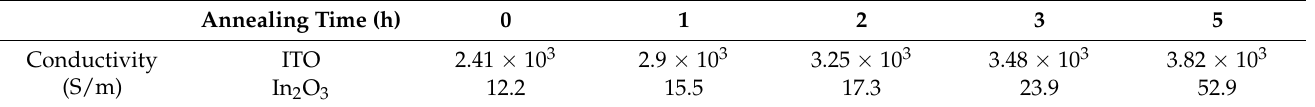
Table 1. The conductivity of ITO and In 2 O 3 annealed at different